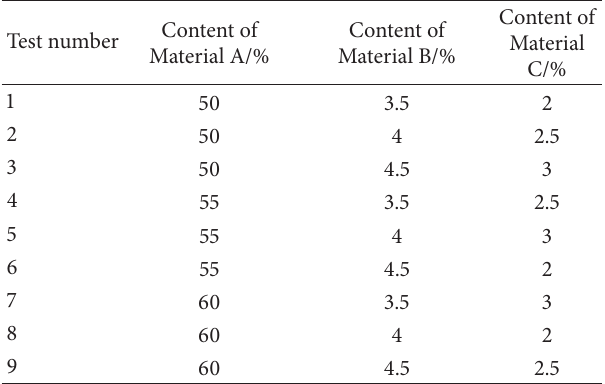
Table 9: Orthogonal test